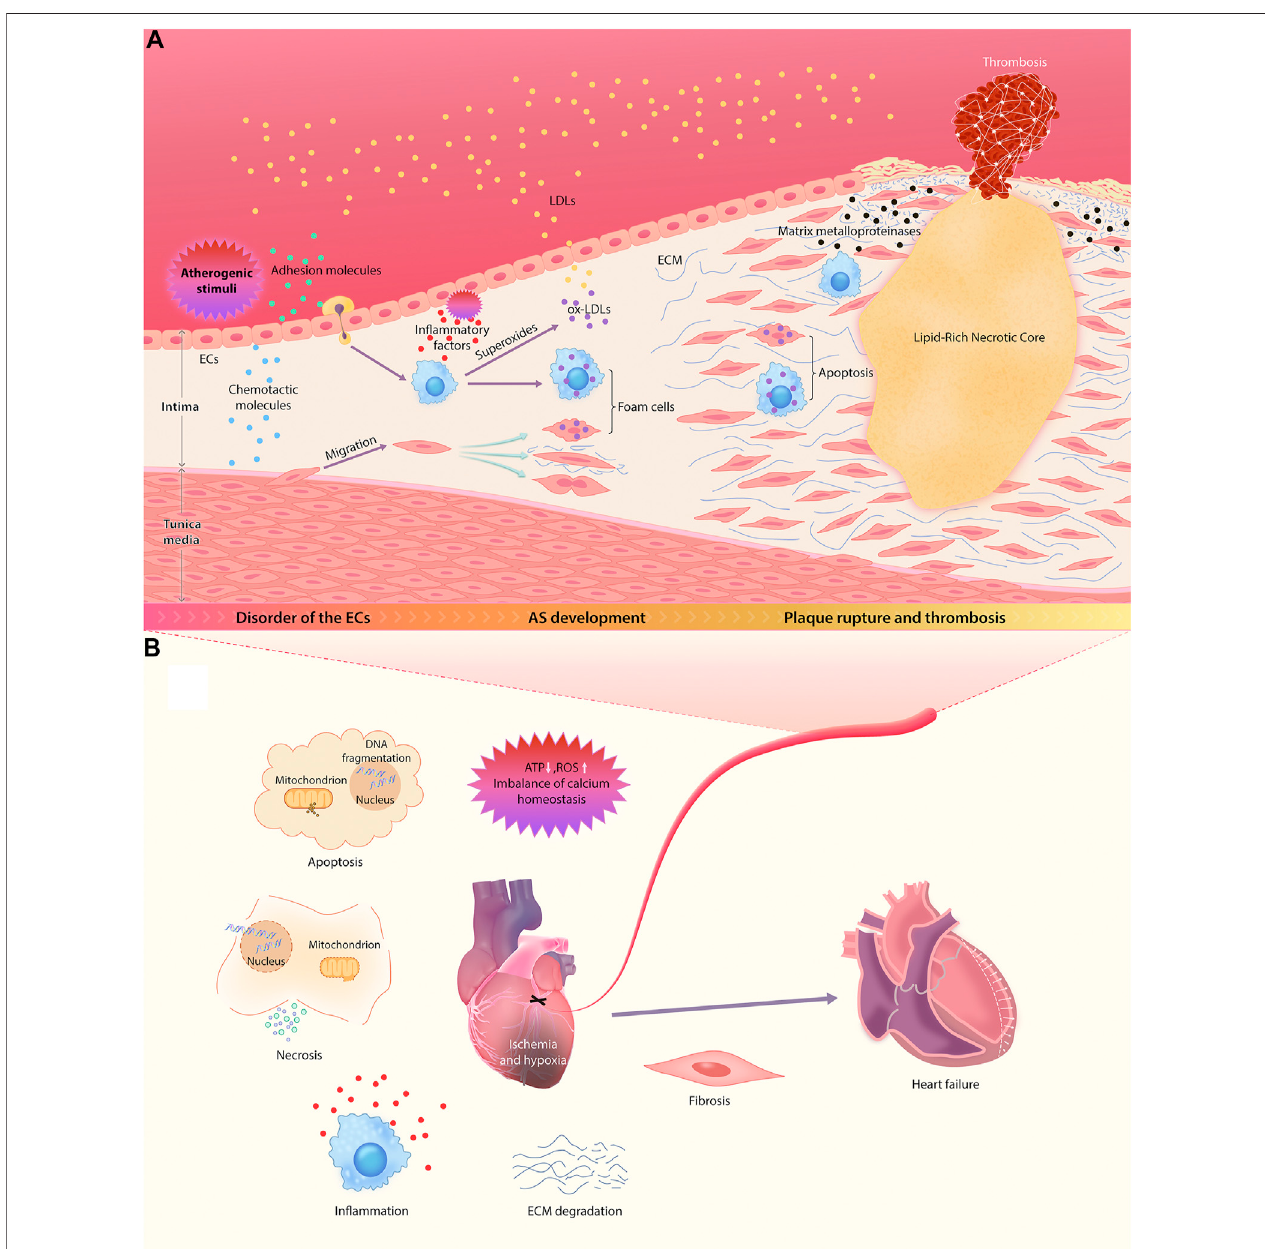
FIGURE1| PathophysiologicalmechanismsofASCVD. (A) ThesequentialmultistepprocessofAS,startingfromendothelialdysfunctionandendingintherupture of unstable plaque. (B) The main mechanisms of the occurrence and development of myocardial injury and ventricular remodeling after the occlusion of diseased coronary